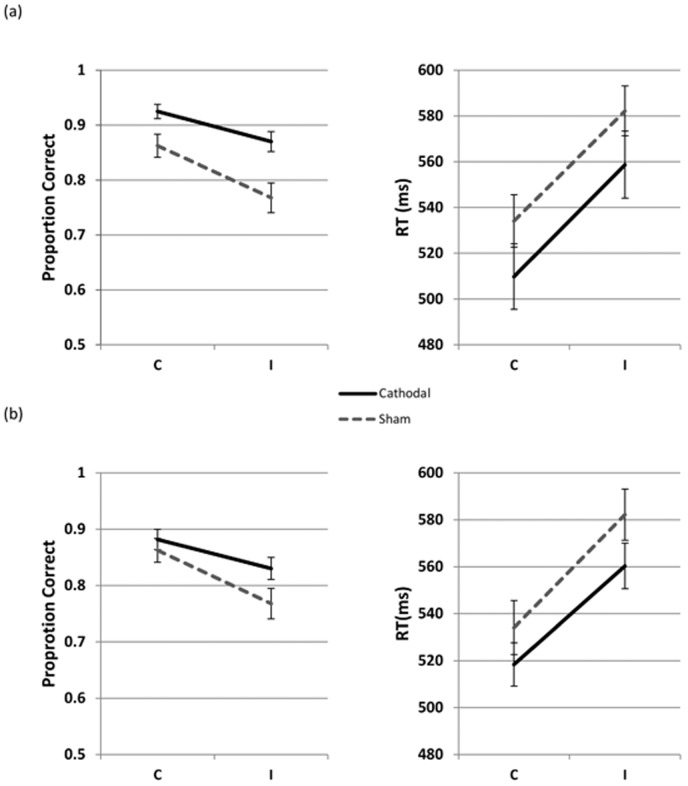
Mean accuracy and reaction times (± SE) in the Flanker task in Experiment 2.(a) Data from Experiment 2a (post-tDCS; right mastoid as the reference electrode site). (b) Data from Experiment 2b (post-tDCS; right supraorbital area as the reference electrode site). In both experiments stimulation was applied during an activity requiring low cognitive control. C  =  Congruent; I  =  Incongruent.